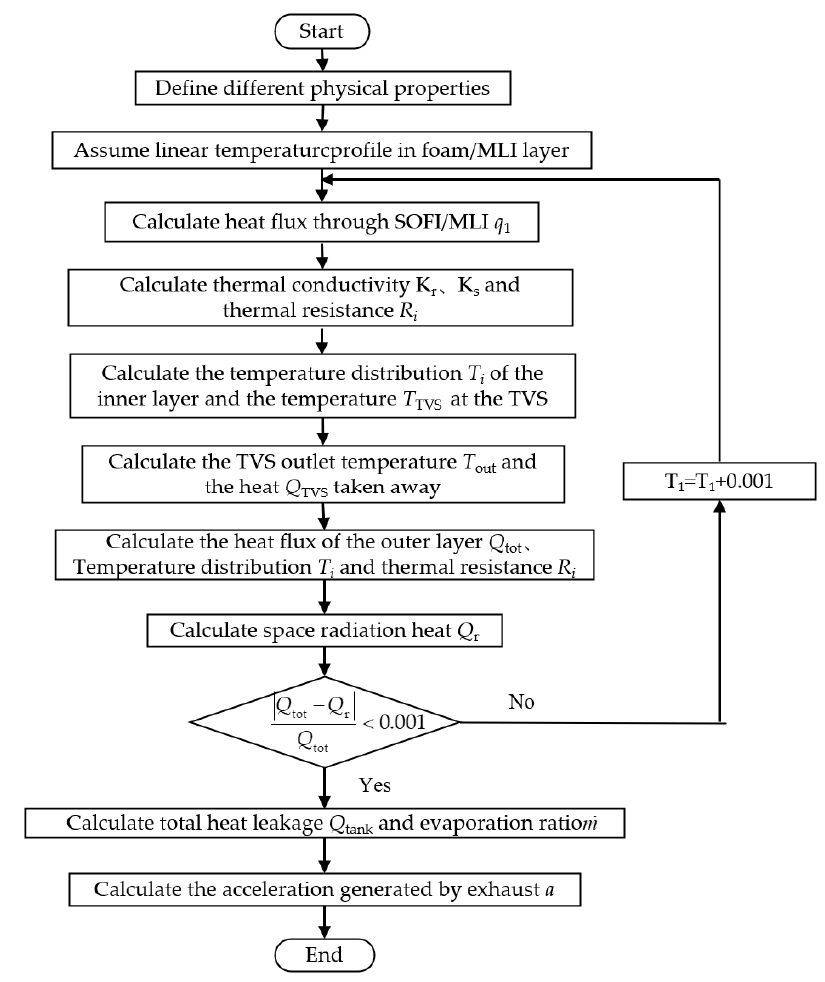
Figure 4. Flow chart of layer-by-layer method for MLI and VCS.